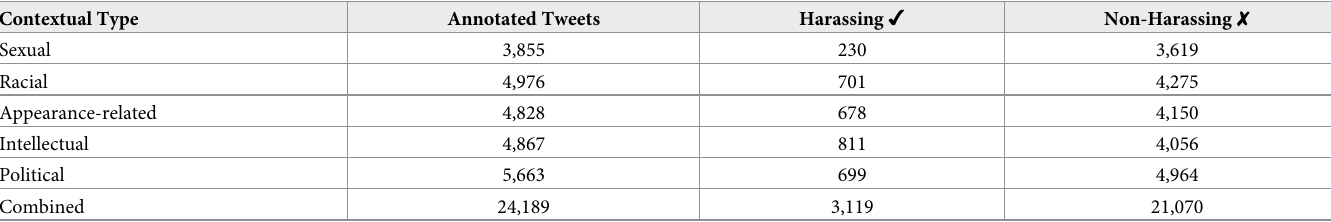
Table 2. Annotation statistics of our categorized